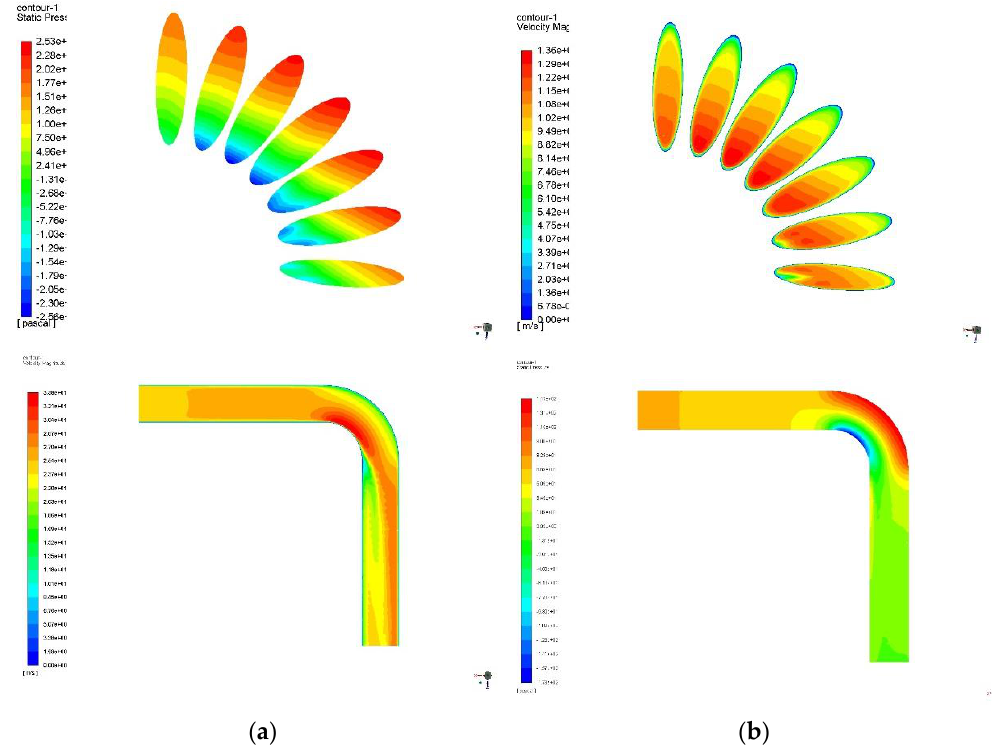
Figure 9. Contours of pressure and gas velocity. ( a ) Pressure distribution in elbow; ( b ) Gas velocity distribution in elbow.